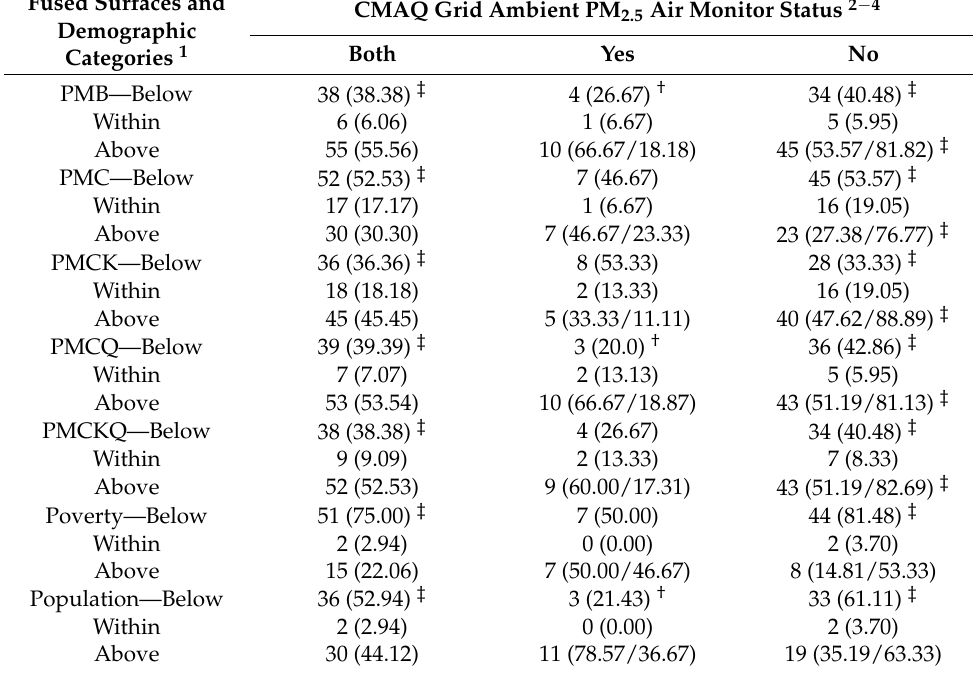
Table 6. Categorical analyses of fused surfaces, poverty percent, and population density by monitor status in the Baltimore study